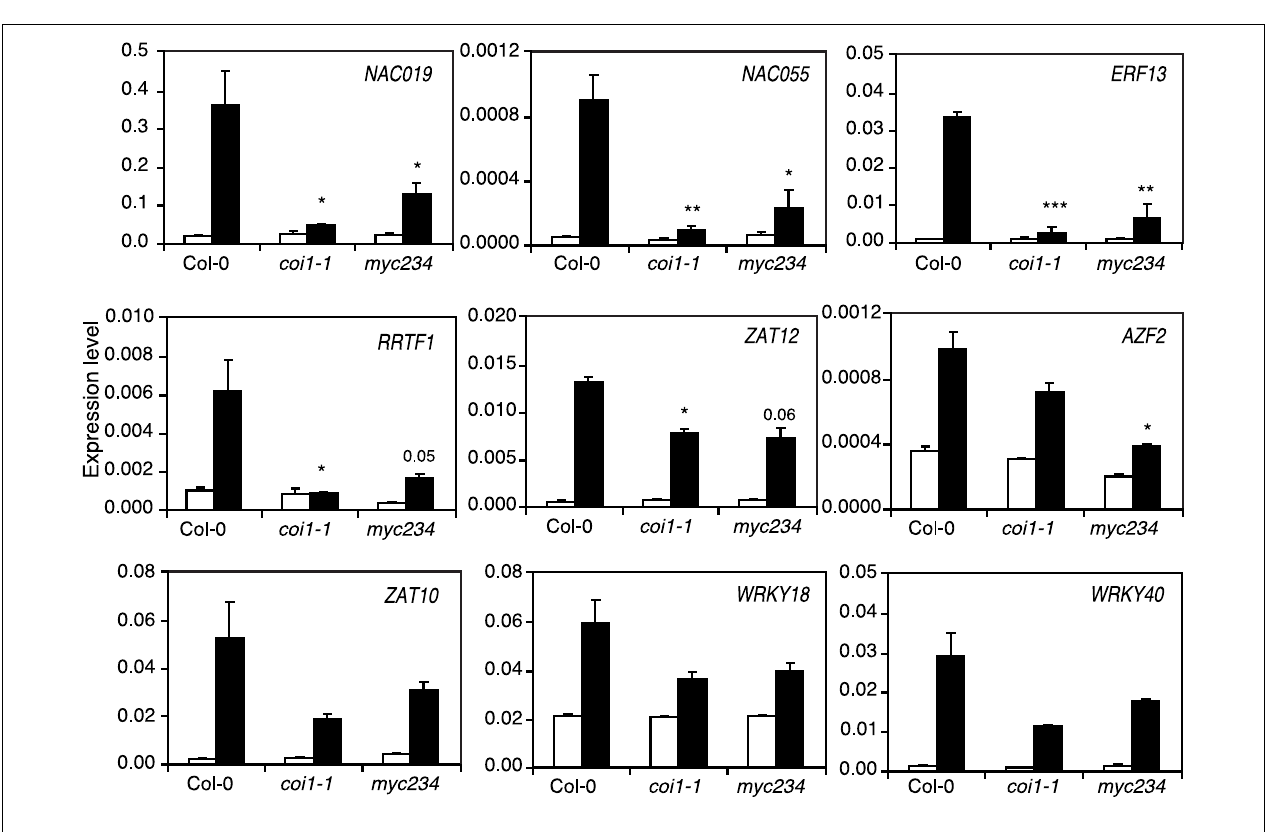
(black bars).Values are the mean ( ± SE) of three biological replicates. Asterisks indicate statistically significant differences in treated plants